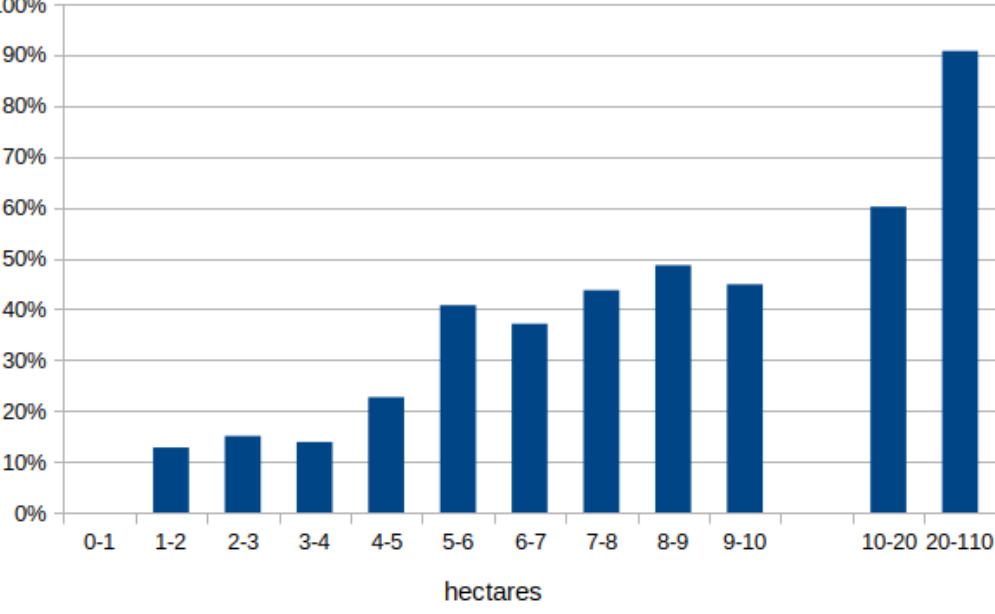
Figure 6. Incidence of certified and still active farms as compared with the total number of certified farms (active and ceased), according to their size.